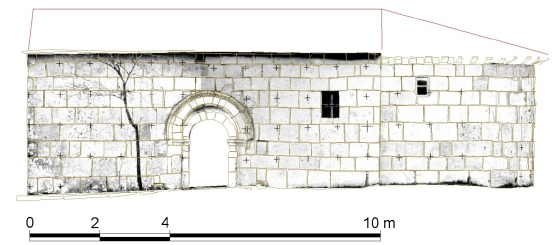
Figure 17. Orthoimage of the southern elevation of the hermitage of Andra Mari -generated from the 3D model with photographic textures- with the original line drawing